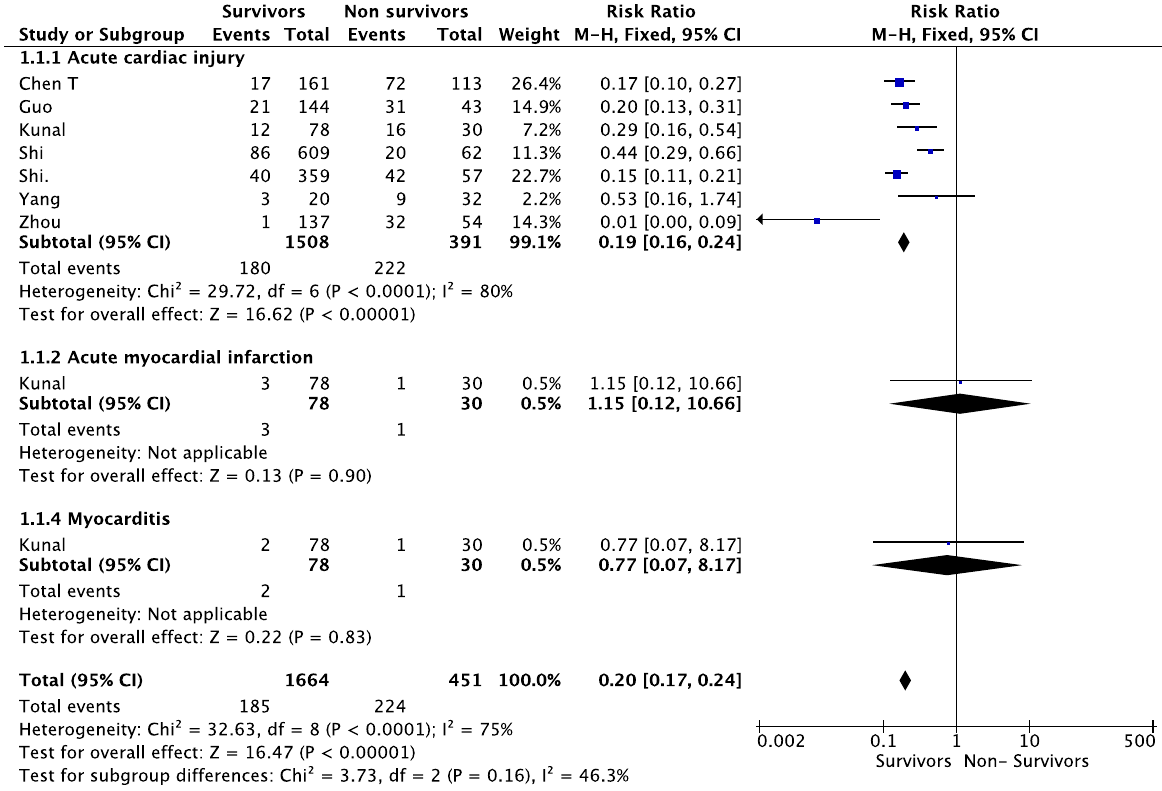
Fig. 3 Forest plot for cardiac complications and mortality between survivors and non-survivors. The black diamond at the bottom of the graph represents the average effect size whereas the horizontal line represents the 95% confidence interval (CI). A random-effects model was used. The sample size, the overall effect, 95% CI, and heterogeneity are